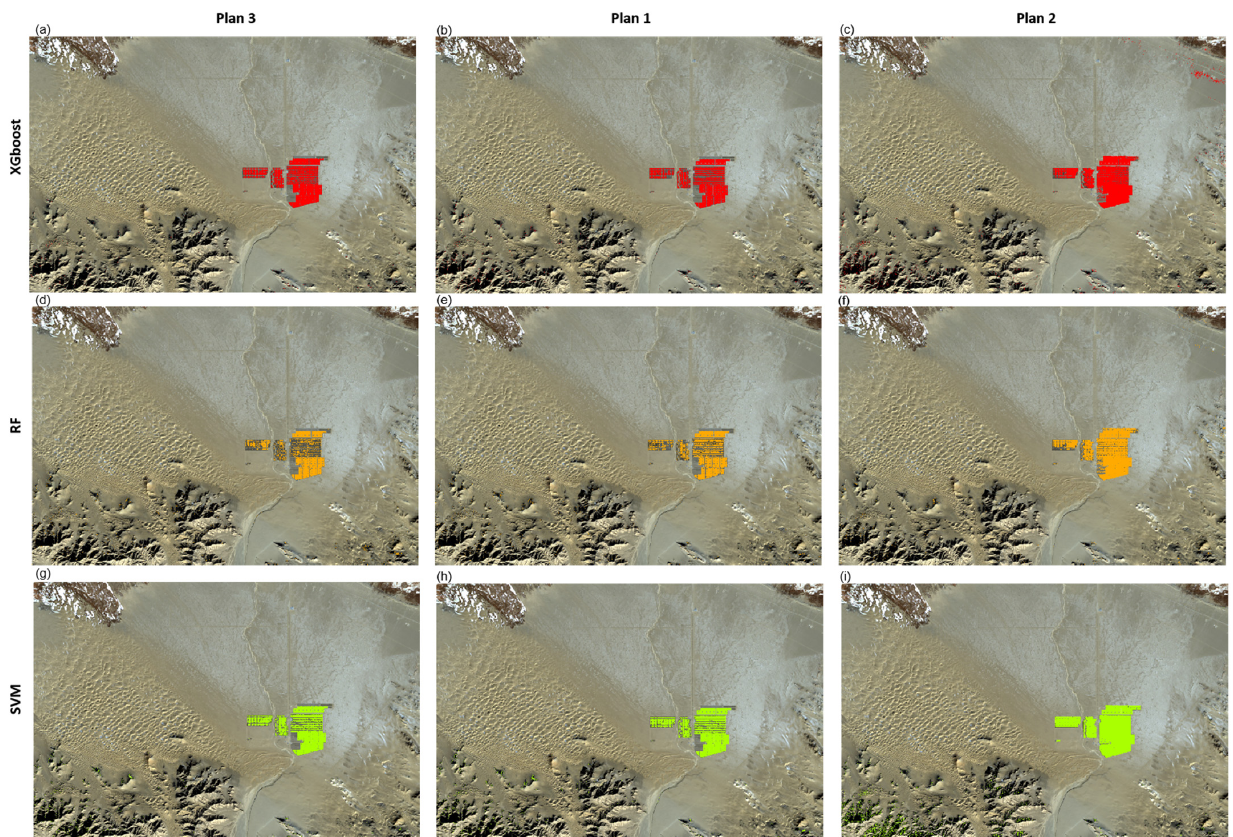
Figure 8. Images showing results of the extraction of PV plants in the central part of the Qaidam Basin using different models (shown as rows) and plans (displayed at the top of columns). Red ( a – c ), yellow ( d – f ), and green ( g – i ) represent the PV extraction results for XGBoost, RF, and SVM, respectively, with Plan 3 yielding the best results for red (XGBoost).